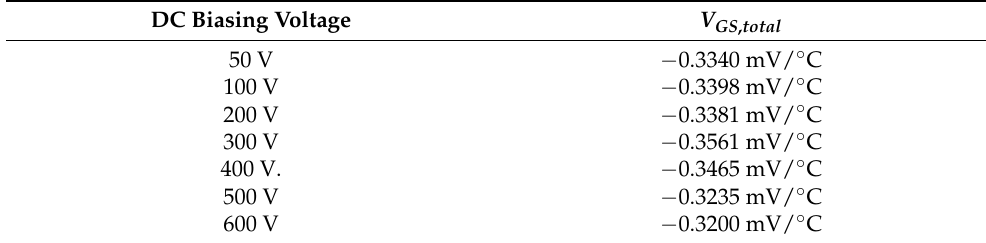
Table 2. Sensitivity of V GS , total at different DC biasing.